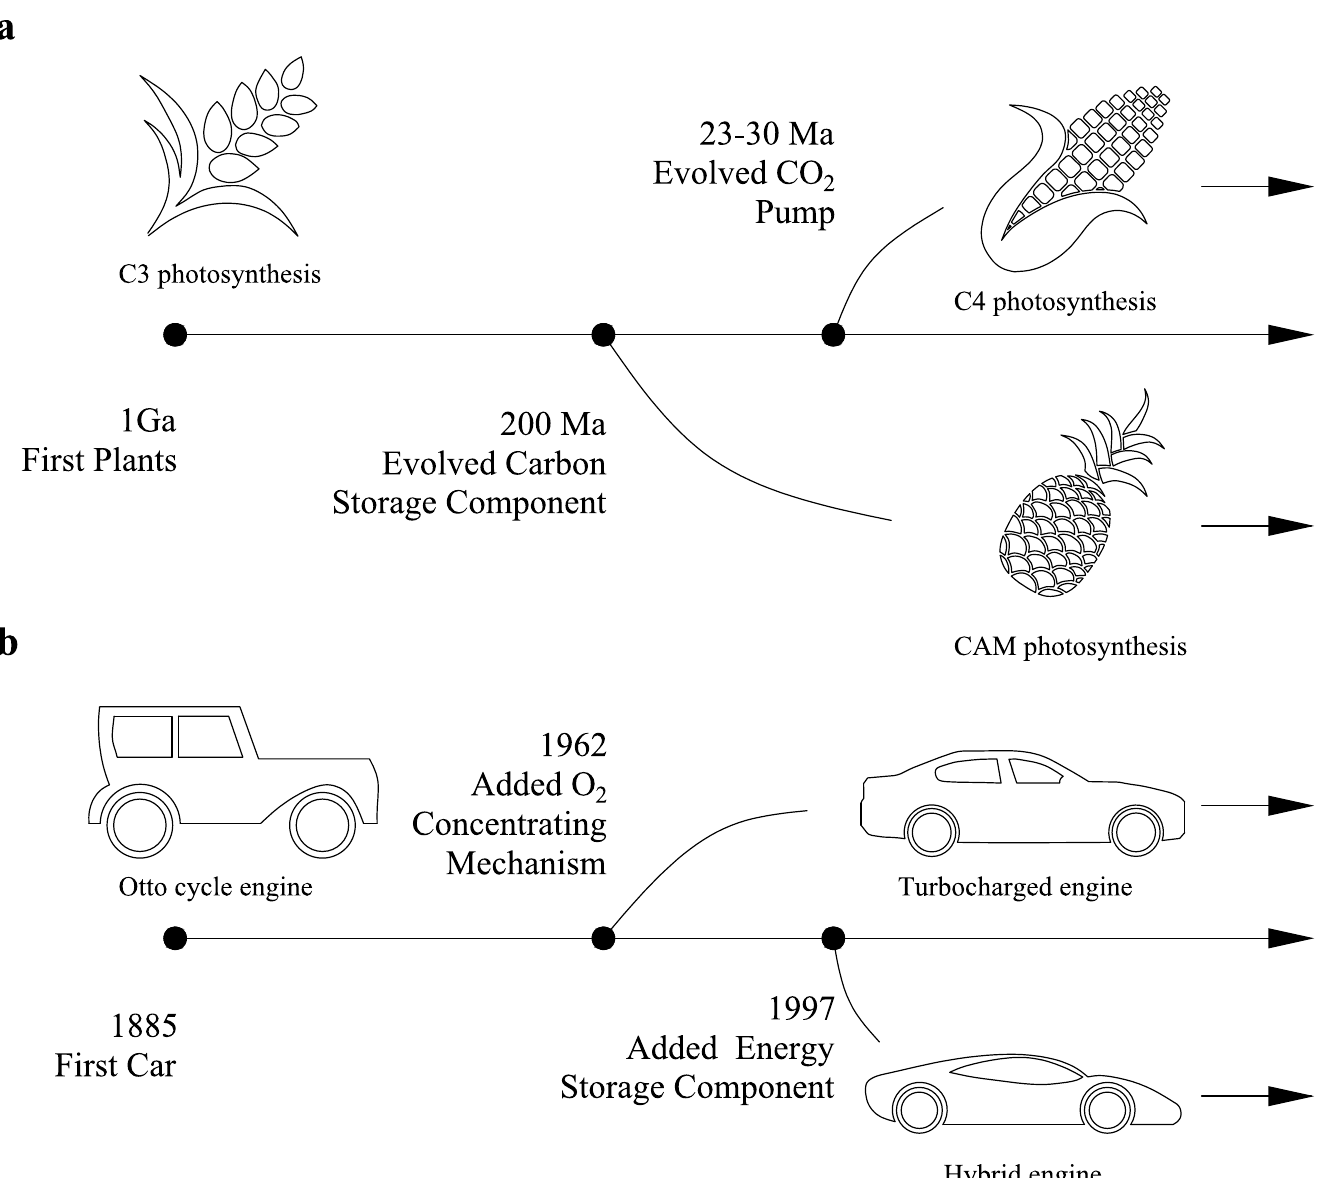
Fig 1. Comparative evolution of plants and cars. (a) In 1885, Karl Benz was among the automobile’s first producers, and in 1908, the Ford Motor Company pioneered the first mass produced automobile, the Model T [5]. The turbocharger gained popularity during World War II, when it was used in military aircraft, which had to cope with low-pressure, high-altitude air [3], and the first turbocharged passenger car, the Chevrolet Corvair Monza, debuted in 1962 [10]. Serious interest in hybrid technology arose in the 1960s when it was recognized as a means for harnessing variability in driving conditions to lower fuel use and emissions, and the Toyota Prius was introduced in 1997 as the first mass produced hybrid car [5]. (b) The first C3 plants developed around 1 Ga ago as aquatic lifeforms [6]. CAM photosynthesis evolved during the Paleozoic era and likely experienced a significant expansion in terrestrial plants in the Cenozoic era, which was accompanied by increasing seasonality of water availability [4]. C4 photosynthesis is thought to have first evolved in the mid-Tertiary period and experienced a large increase in the late Miocene, 4-7 Ma, which brought decreasing CO 2 levels